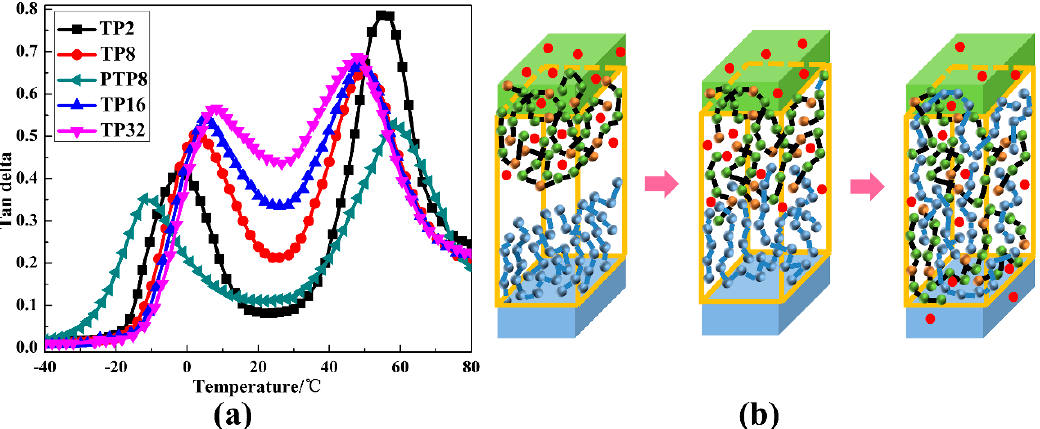
Figure 9. ( a ) The tan δ versus temperature curves of the TP and PTP multilayer system and ( b ) the structural schematic diagram of the TP system (cyan ball and line represent the PVAc chain at interface, cyan layer represents the PVAc layer, red ball represents AO-70, green layer represents the TPU layer and green and yellow ball combined with a black line represent the TPU chain at interface). Table 1. The damping properties of the TP and PTP multilayer system.